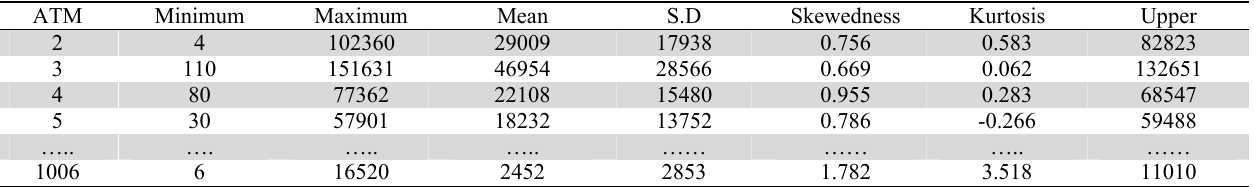
ATMs Daily Cash Withdraw Parameters